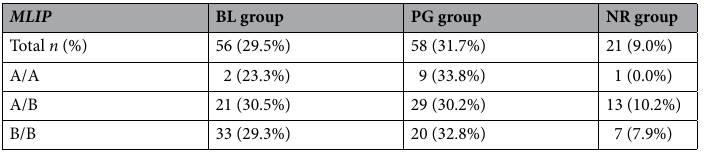
Table 2. Percentage average IOP reduction for responder and non-responder genotype frequencies for MLIP . MLIP , muscular LMNA interacting protein; A, 1 copy allele; B, no copies allele; BL, beta-blocker (timolol maleate) treatment group; PG, prostaglandin analogue (latanoprost) treatment group; NR, patients not responsive for any treatment in monotherapy; n, number of individuals; (%), percentage average IOP reduction.